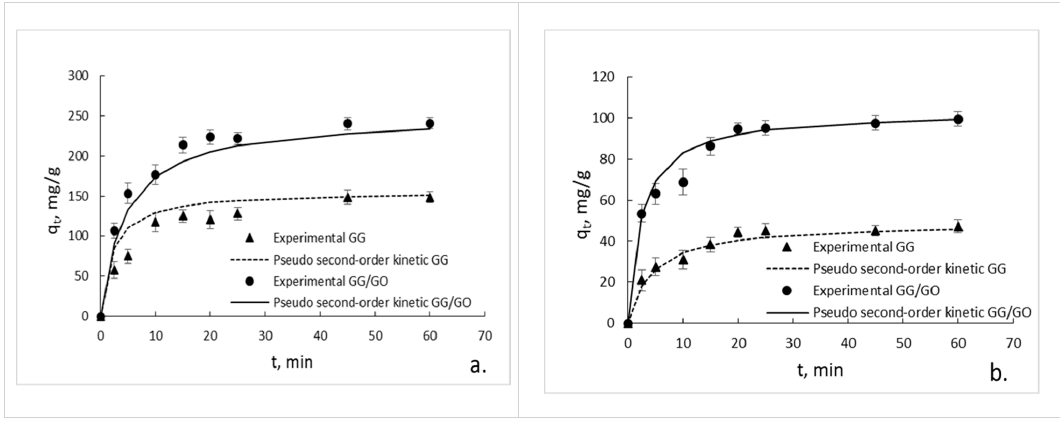
Figure 9. Kinetic curves for Zn (II) sorption on GG and GG/GO sorbents from aqueous solutions under different pH conditions: ( a ). GG and GG/GO at pH 6; ( b ). GG and GG/GO at pH 3.